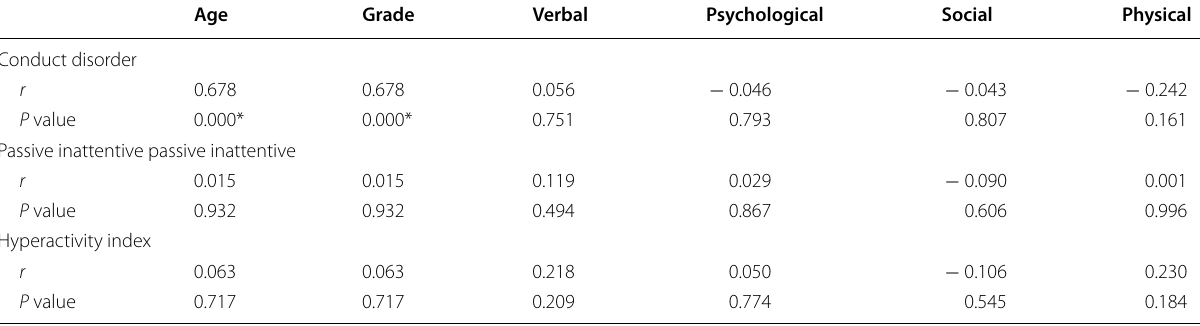
Table 5 Correlation of Conners’ Teacher Rating Scale-28 with age, grade and bullying